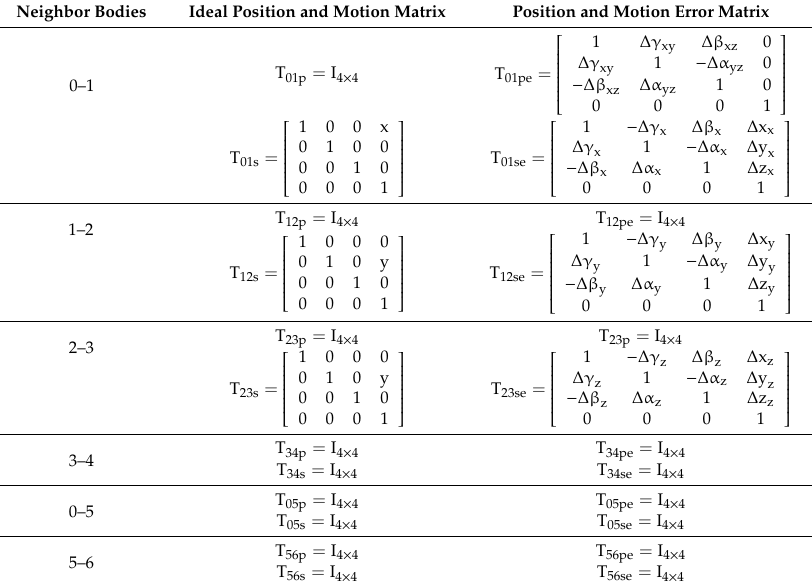
Table 4. The transformation matrix of the chosen caring and mill machine. Neighbor